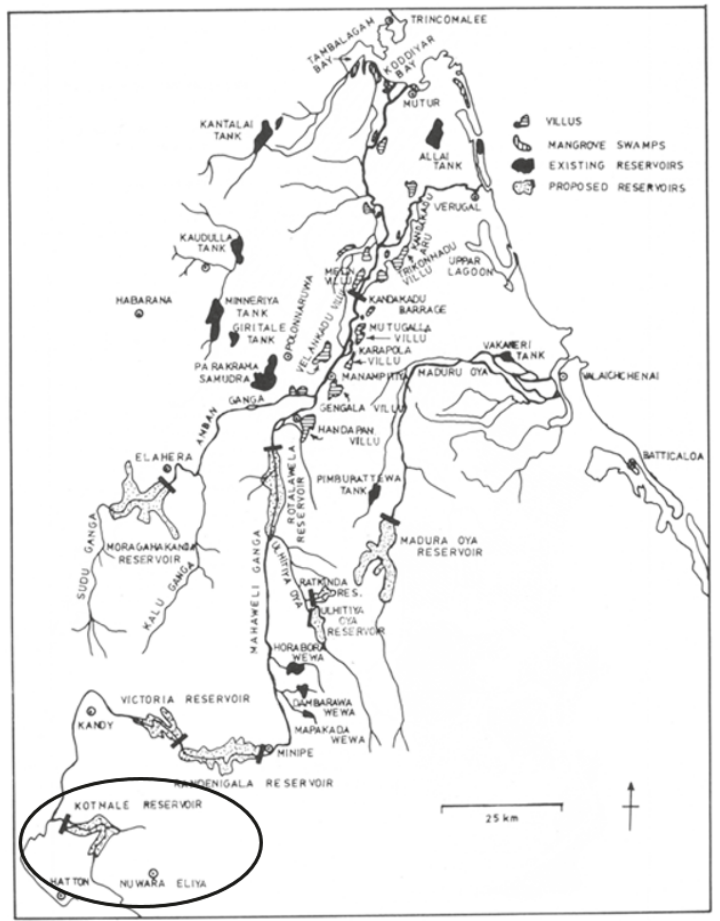
Figure 1: Location of the Kotmale reservoir in Sri Lanka. Source: Food and Agriculture Organization of the United Nation